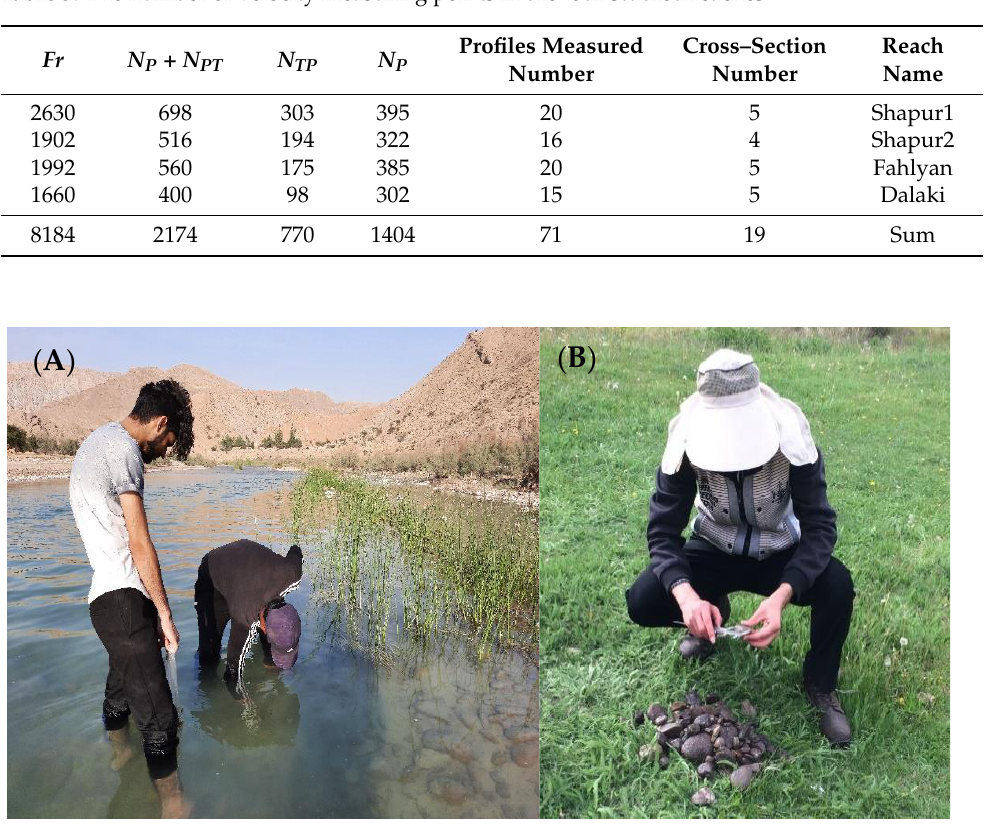
Figure 6. ( A ) Sampling of riverbed sediment, ( B ) measurement of riverbed sediments.